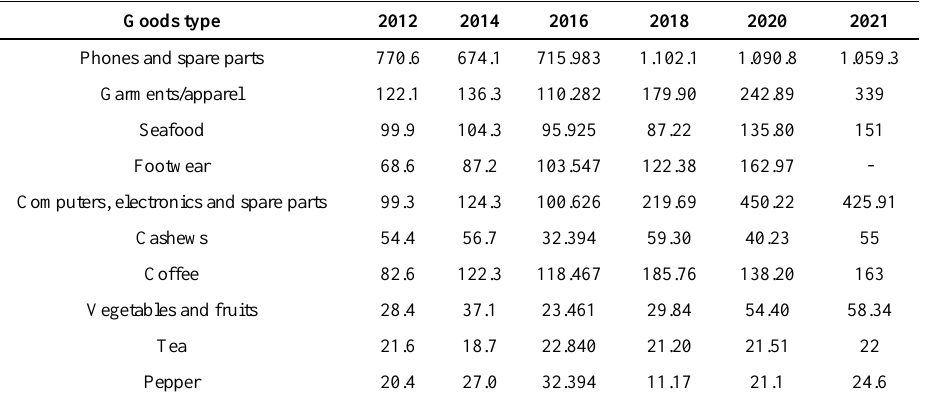
Table 1. Total exports of certain goods of Vietnam to Russia from 2012 – 2021 ( Unit: Million USD)